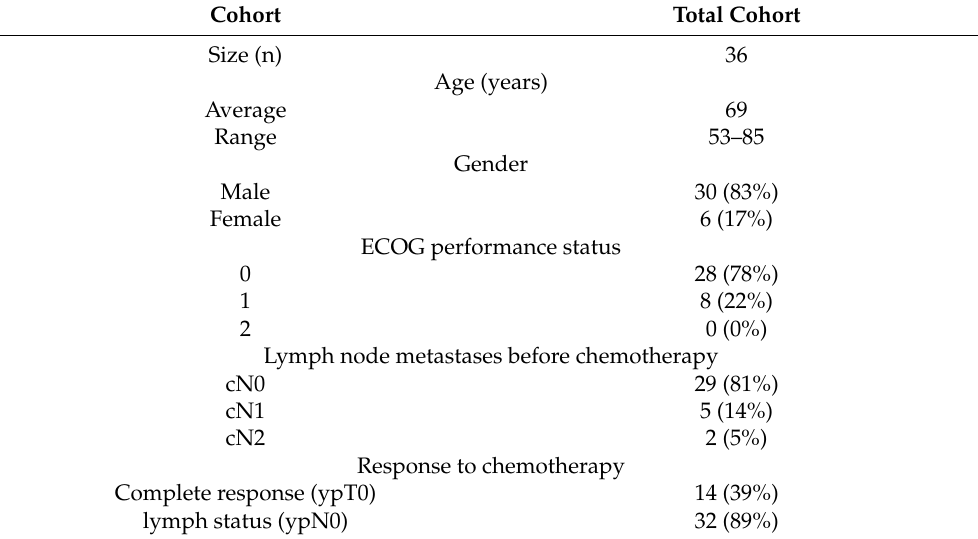
Table 1. Clinical characteristics of patients in the total cohort (n =